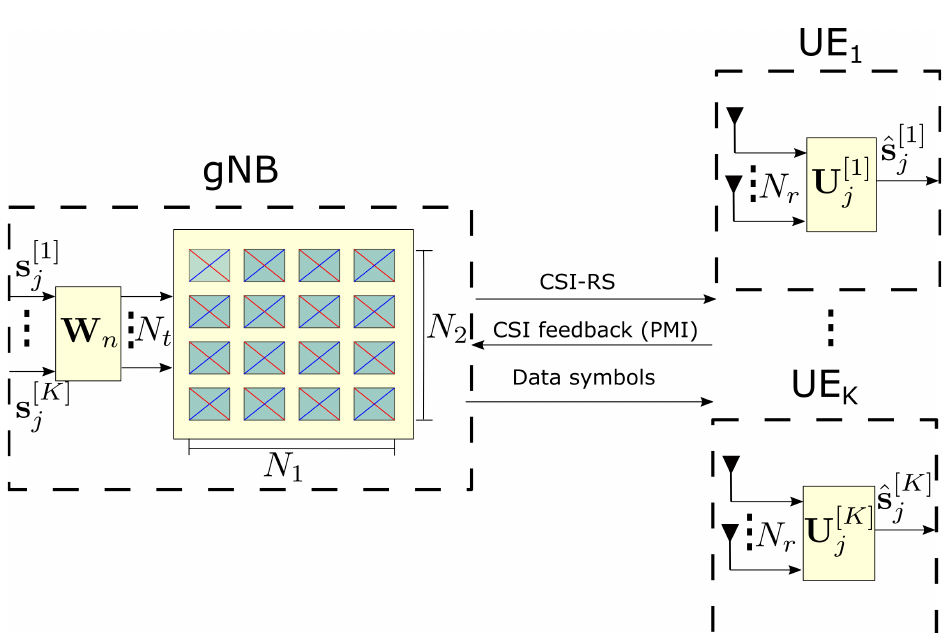
Figure 1. Block diagram of an MU-MIMO downlink transmission in 5G-NR composed of several stages. First, the gNB sends the CSI-RS to each UE. Based on this signal, the channel is estimated at each UE and a CSI is fedback, including the PMI. With this information, the gNB designs the precoding matrix. Finally, the precoded data symbols are transmitted to each UE avoiding